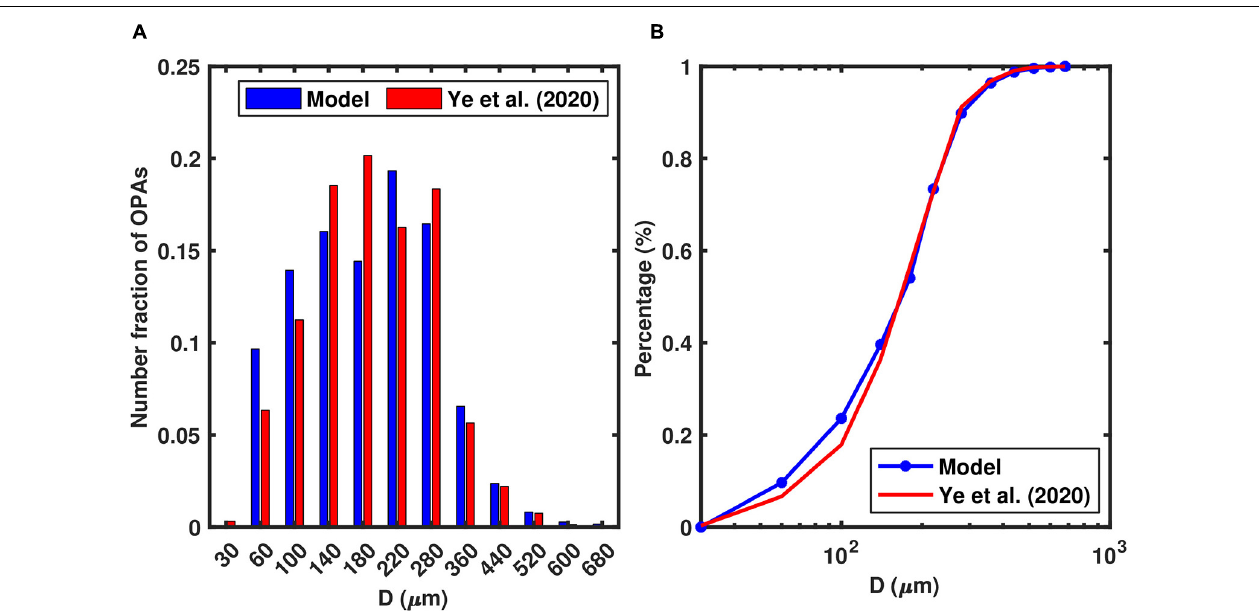
FIGURE 3 | Comparison of the number fraction of oil-bentonite aggregates between the lab experiments (Ye et al., 2020) and 0-D model that included OPAMOD after a simulation time of 2 h. (A) Histogram of OPA sizes, (B) Cumulative number percentage of OPAs.